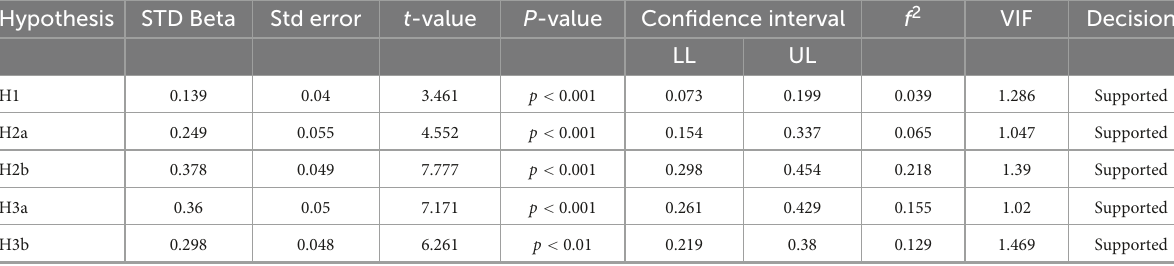
TABLE 7 Results of the structural model analysis (direct relation).